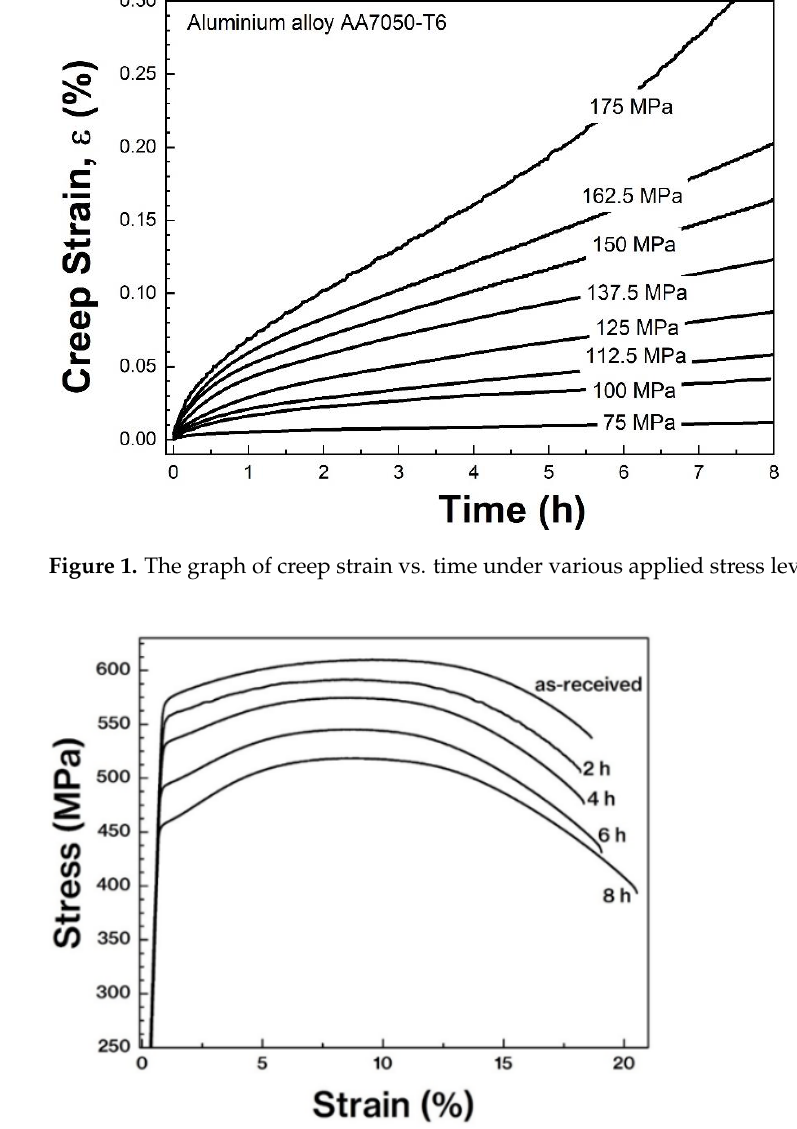
Figure 2. The stress-strain curves of AA7050-T6 alloy at the as-received and pure ageing condition. The elongation at break conversely decreased from the as-received condition of 18.7% to 18.1% after pure ageing for 2 h, and later increased to 18.4% after pure ageing for 4 h, 19.1% after pure ageing for 6 h, and 20.6% after pure ageing for 8 h. Figure 3 depicts the relationship of yield strength (0.2% offset) vs. creep ageing time. In general, the material presented an over-ageing behavior; the yield strength dropped as ageing time rose. The highest yield strength of the alloy, about 574 MPa, was achieved at the as-received. After 4, and 8 h of pure ageing, this number rapidly decreased to 534 MPa and 455 MPa, respec- tively.